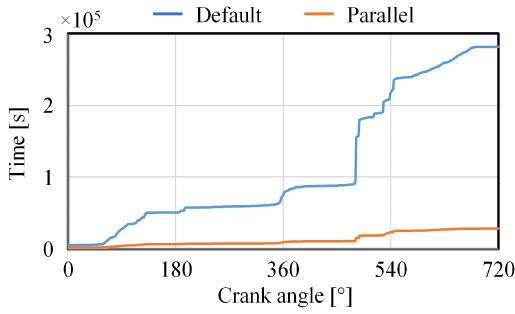
Figure 9. Cumulative elapsed time of the piston–liner multibody dynamics simulation with elasto- hydrodynamic lubrication. The values are plotted depending on the crankshaft angular position.